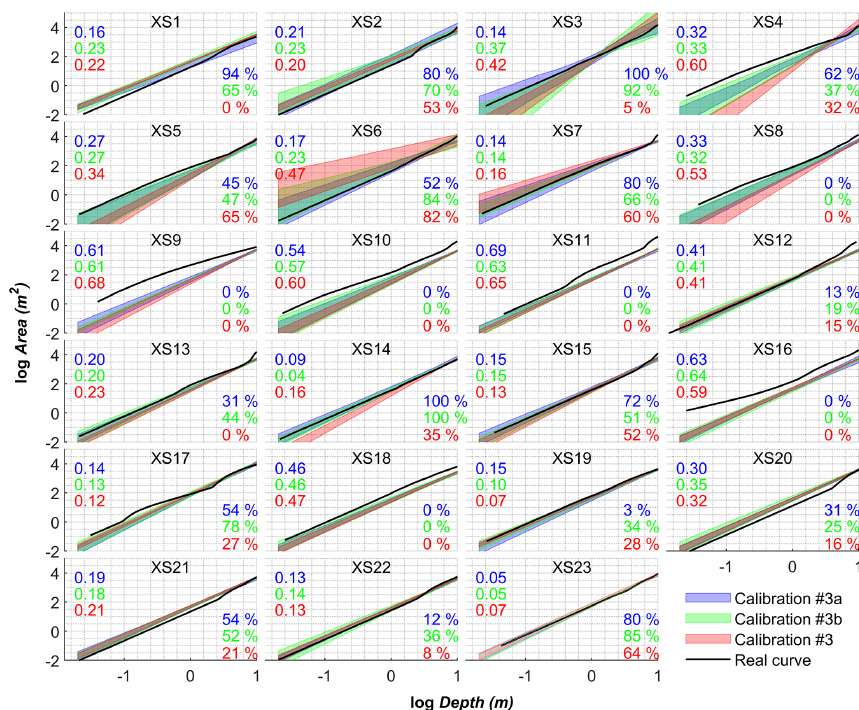
Figure B3. Calibrated curves using three scenarios of width observations and water level, i.e., one width observation per 5km reach and water levels (calibration #3a), one width observation per 2km reach and water levels (calibration #3b), and all available widths and water levels (calibration #3). The color band represents the mean ± standard deviation based on an ensemble of 10 calibrations. The number of cross-section is given in each plot. RMSE and coverage (percentage of real data falling into the calibrated interval) of calibrated curves against real data are reported on the left and right sides of each plot, respectively. Font color is consistent with the curve color. The average RMSE and coverage values are 0.28, 0.29, and 0.34 and 41%, 42%, and 24% for calibration #3a, #3b, and #3,